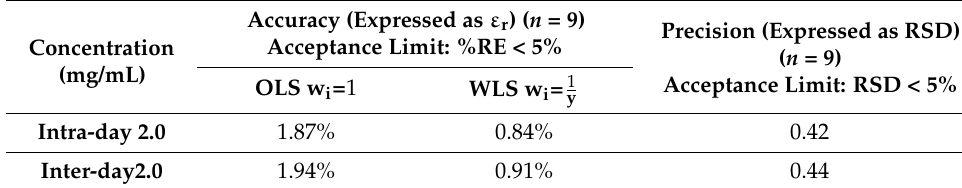
Table 4. Accuracy and precision of the HPLC method.